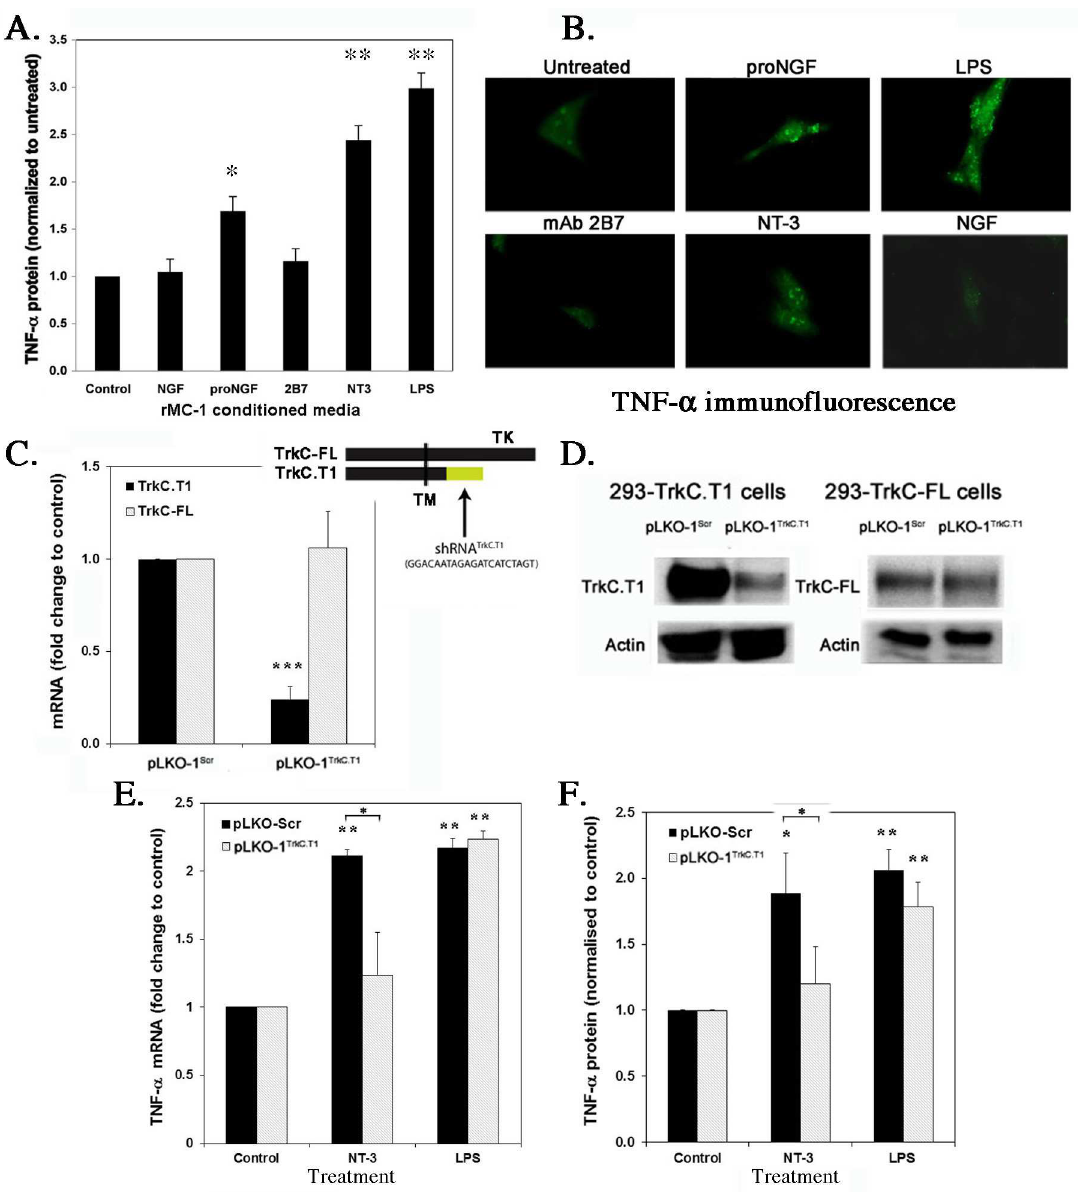
Fig 3. NT-3–dependent induction of TNF- α is TrkC.T1–mediated. ( A ) The glial rMC-1 cell line expressingendogenous TrkC-FL and TrkC.T1, and p75 NTR were treated for 6 hours (NGF 2 nM, proNGF 0.5 nM, 2B7 100 nM, NT-3 10 nM, LPS 1 μ g/ ml). From conditioned media the levels of soluble TNF- α protein were quantifiedby ELISA. Data are standardized to untreated control. Average ± SEM, n = 3 independent experiments each in triplicate. * p < 0.05, ** p < 0.01 versus control. ( B ) The levels of cell-associated TNF- α protein were studied by immunofluorescence. ( C ) The mRNA levels of TrkC-FL and TrkC.T1 were quantifiedby PCR, after infection with lentivirus pLKO.Scr (scrambledcontrol) or with pLKO.1 (expressing a uniqueshRNA targeting TrkC.T1 mRNA specifically). Results are normalizedto reference GAPDH mRNA. Data are expressedas the mean + SEM; n = 3 independent experiments each in triplicate. The inset shows a western blot for TrkC-FL or TrkC.T1, from detergent lysates preparedfrom the cultures. ( D and E ) The levels of TNF- α mRNA or protein were quantifiedby PCR or by ELISA after infection with pLKO.Scr or pLKO.1. Data are standardized to untreated control. Average ± SEM, n = 3 independent experiments each in triplicate. ( F) The levels of TNF- α mRNA in were assessed by quantitativePCR from spinal cord of ALS G93A versus wild type mice. Results were normalizedto GAPDH. Data